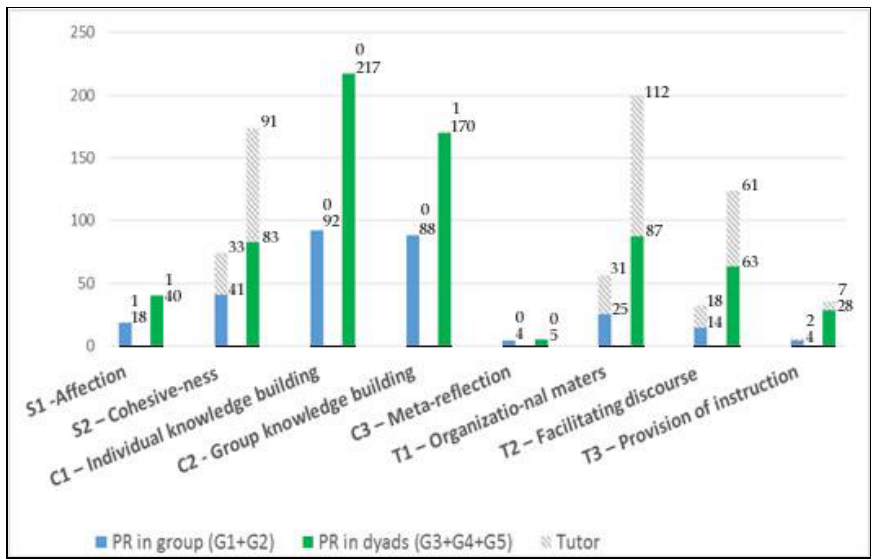
Figure 4. Units detected per indicator category and per condition (PR in groups vs. PR in dyads) + units by tutor in the two